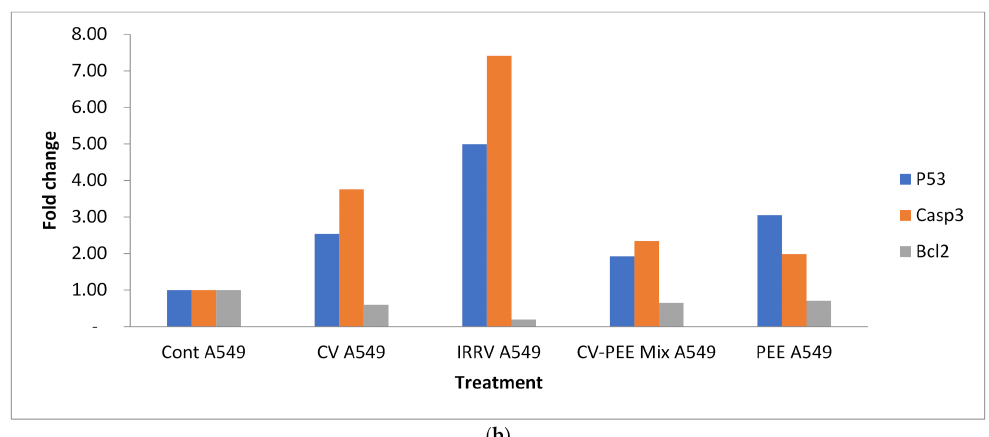
Figure 5. ( a ) Detection of PC3 cell line apoptosis-related genes in CV, IRRV, CV-PEE Mix, and PEE compared to untreated cell control using real-time PCR. ( b )Detection of A549 cell line apoptosis-related genes in CV, IRRV, CV-PEE Mix, and PEE compared to untreated cell control using real-time PCR.